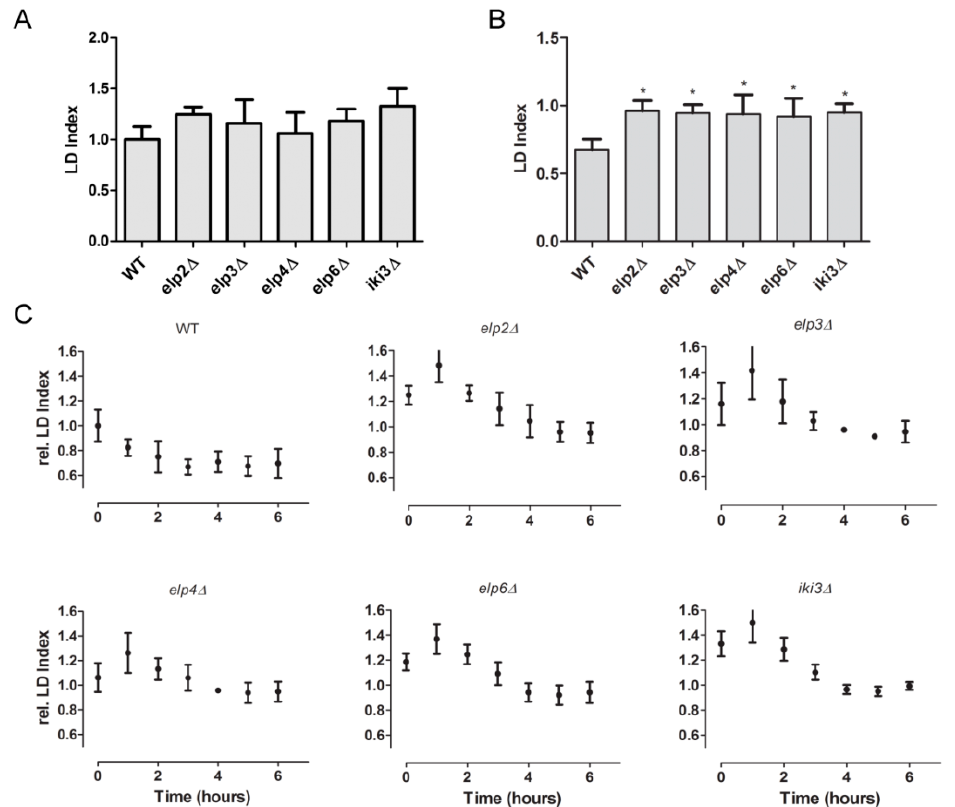
Figure 3. Lipid droplet (LD) content and dynamic change in Elongator mutants as compared to the wild type (WT). Elongator mutant strains were pre-grown to stationary phase (48 h) to attain a high LD content and then seeded at low density in YPD medium at 30 °C ( A ) Aliquots were withdrawn at stationary phase (48 h) or ( B ) after 5h of growth. ( C ) Lipid droplet dynamics of Elongator mutants was studied during the exponential phase (lipolytic phase) of growth. Stationary cells were seeded at 0.25 O.D 600 nm in YPD. Aliquots were withdrawn at the times indicated and fixed in formaldehyde 3.7%. Afterwards the LD index was measured with the liquid fluorescent recovery (LFR) assay using Bodipy 493/503 as a probe [2] and normalized to WT. The mean ± (standard deviation) S.D. of three independent experiments is shown (* p < 0.05).